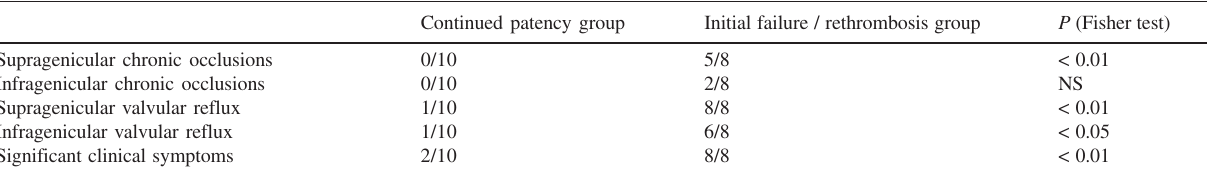
Table 5 - Late results of patients showing venous patency or